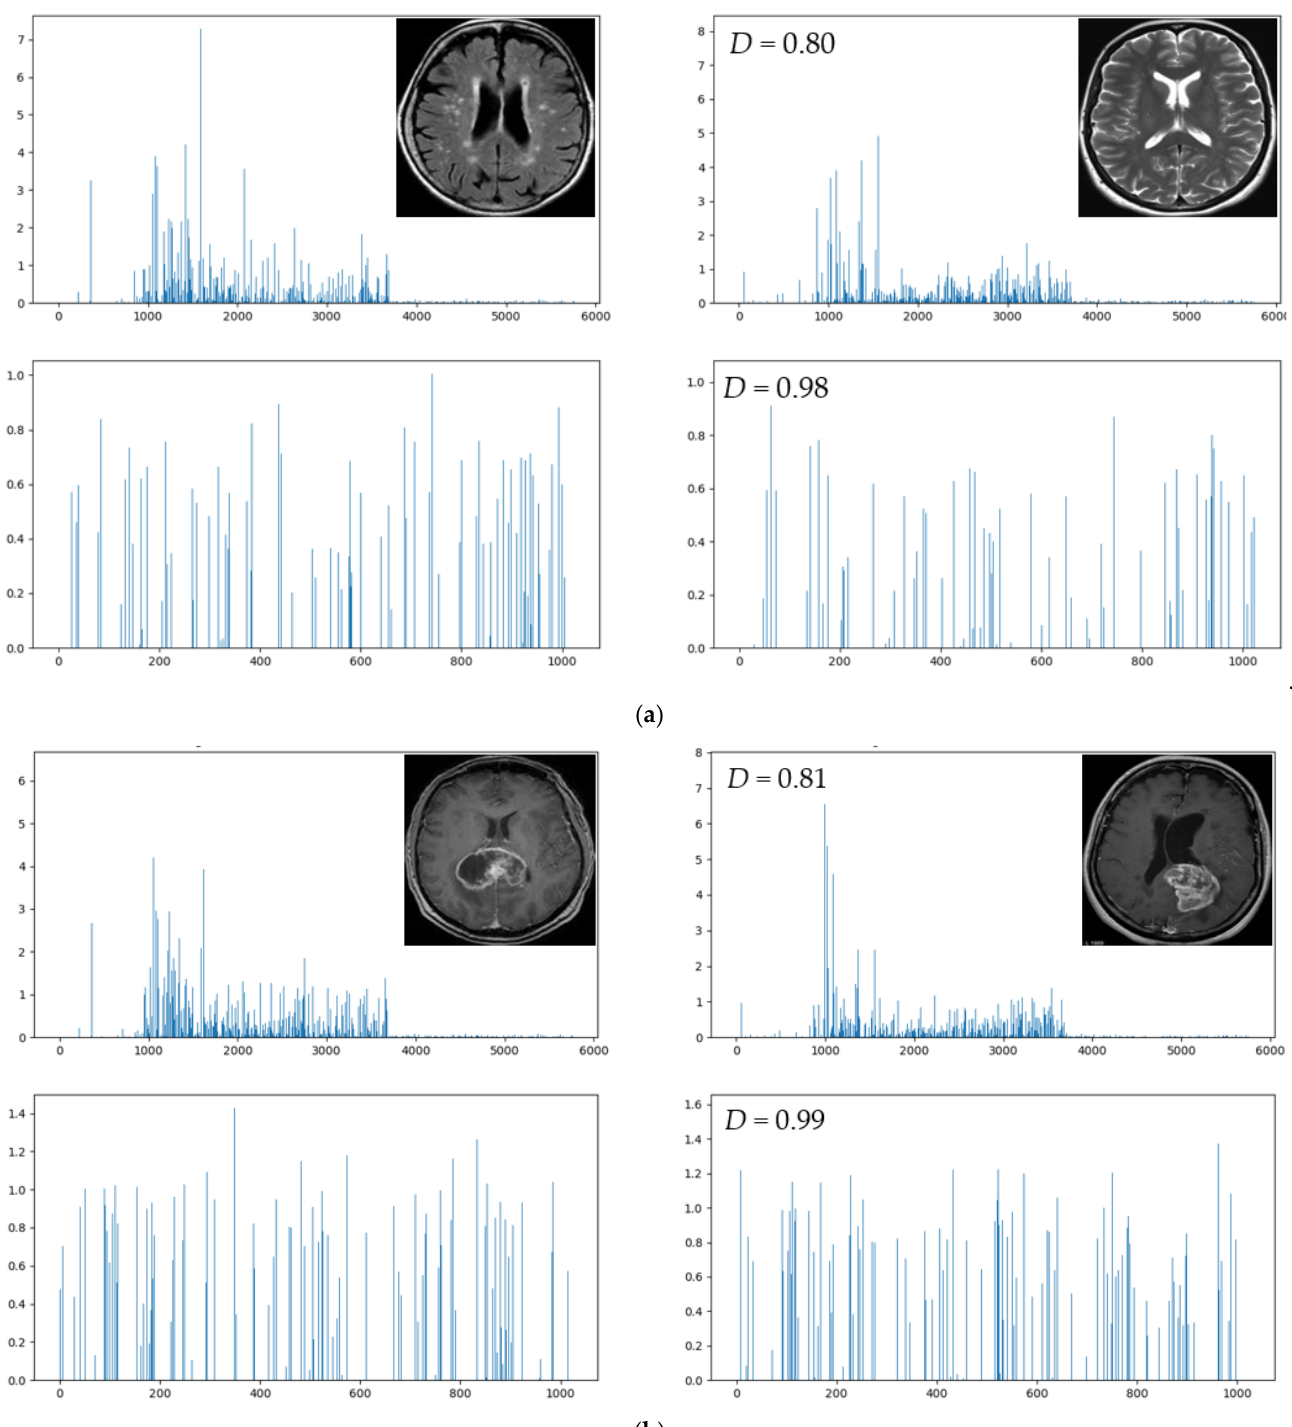
Figure 15. Example of image features extracted using pretrained CNNs (upper rows) and using our proposed FS network (lower rows) in the case of two images in the same class: ( a ) Two different images in the non-tumor class and ( b ) two different images in the tumor class.